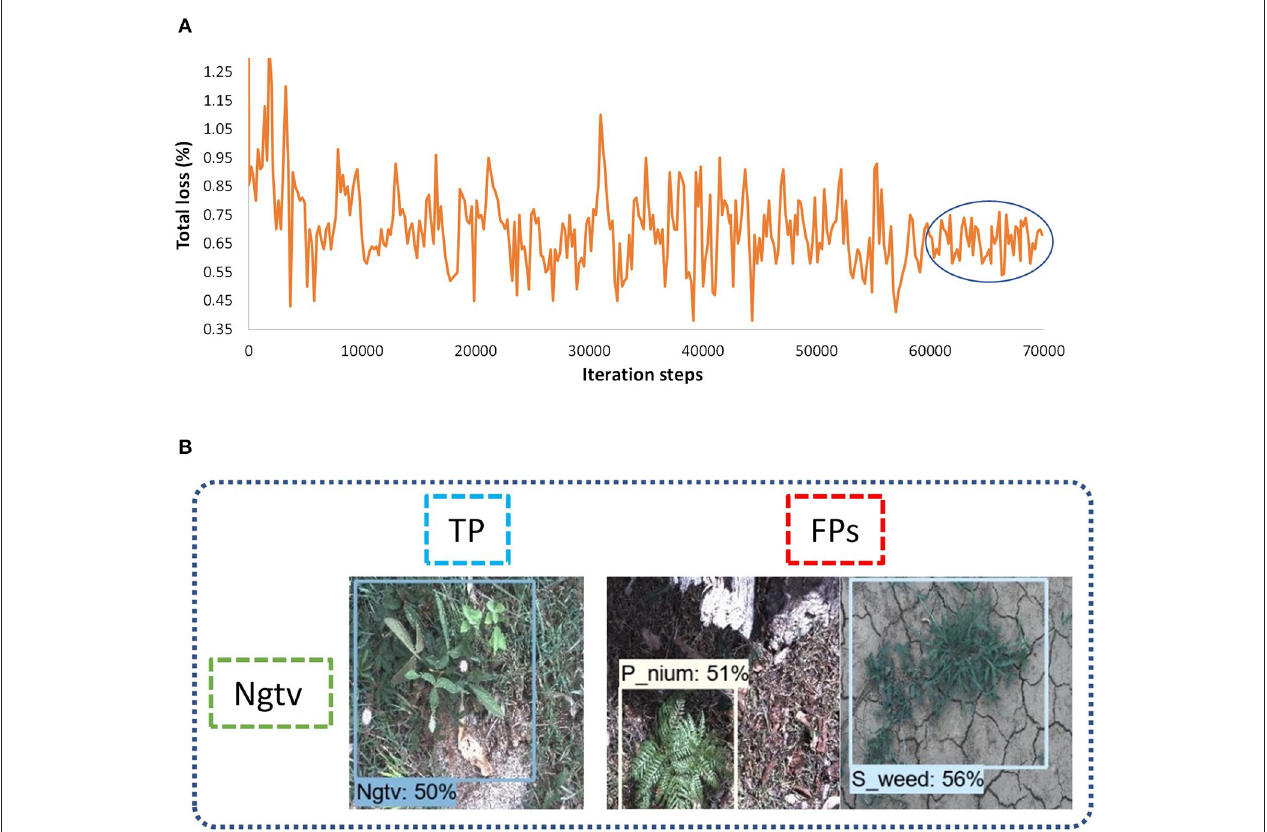
FIGURE 5 | Performance of RetinaNet: (A) total loss plot; (B) examples of false-positive results for the negative